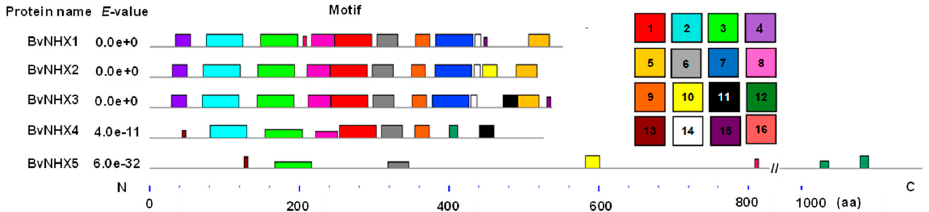
Figure 3. Motif analysis of the BvNHX proteins. Distribution of conserved motifs in BvNHXs was analyzed by the online tool MEME. Details of different motifs indicated by different colors are shown in Supplementary Figure S2. The scale of proteins length was given at the bottom. aa: amino acid.